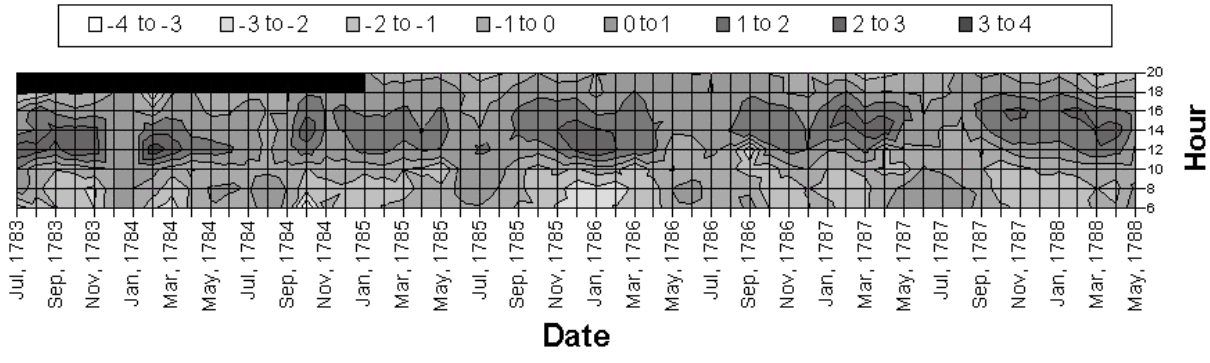
Fig. 2. Monthly average deviations of hourly data (see text for details). Data at 20h between 1783 and 1785 is missing (black stripe). Data for December 1783 and January 1784 was interpolated. All units in minutes of arc. Figure 2. Monthly average deviations of hourly data (see text for details). Deviations Without the original daily data from Sanches Dorta we had to restrict our analysis of the daily cycle variability solely to computed. Data at 20h between 1783 and 1785 is missing (black stripe). Data for December monthly averages recorded for even hours of the day (6 h, 8 h, 10 h, 12 h, 14 h, 16 h, 18 h and 20 h). For each individual 1783 and January 1784 was interpolated. All units in minutes of arc. month between July 1783 and May 1788 (i.e. 59